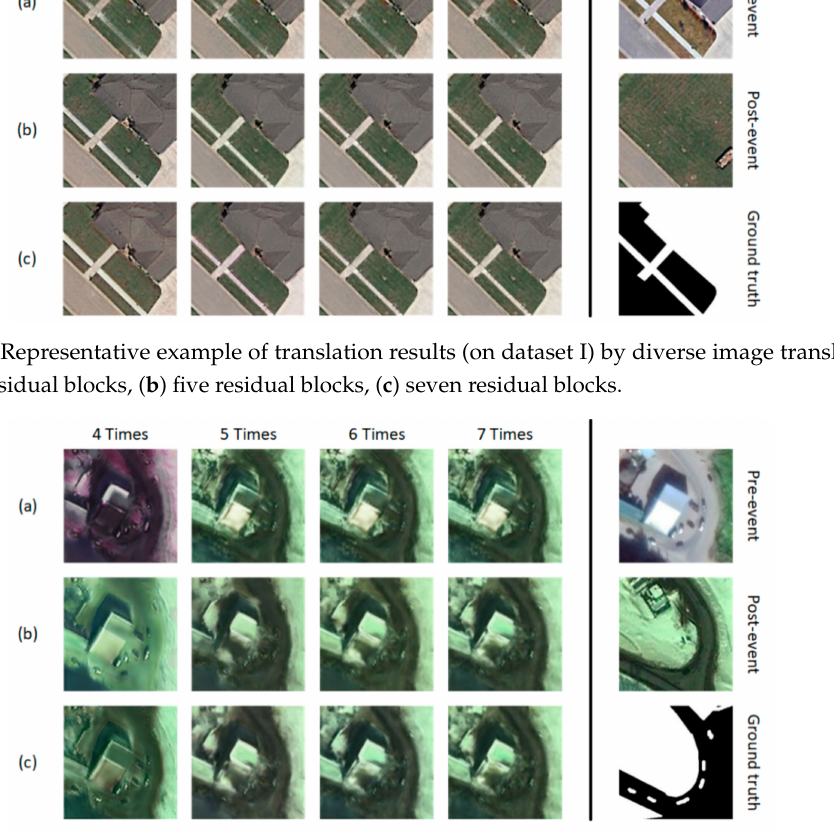
Figure 11. Representative example of translation results (on dataset II) by diverse image translators: ( a ) three residual blocks, ( b ) five residual blocks, ( c ) seven residual